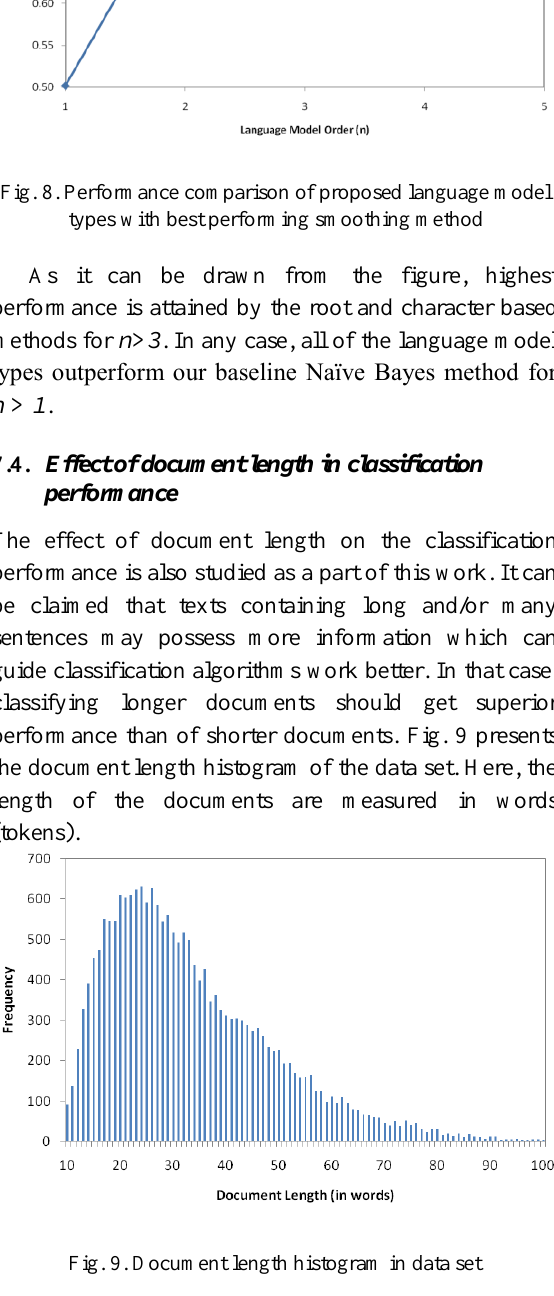
Fig. 9. Document length histogram in data set